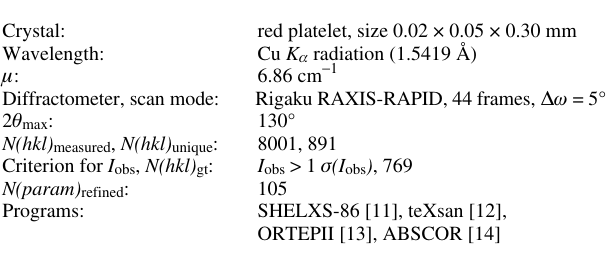
Table 1. Data collection and